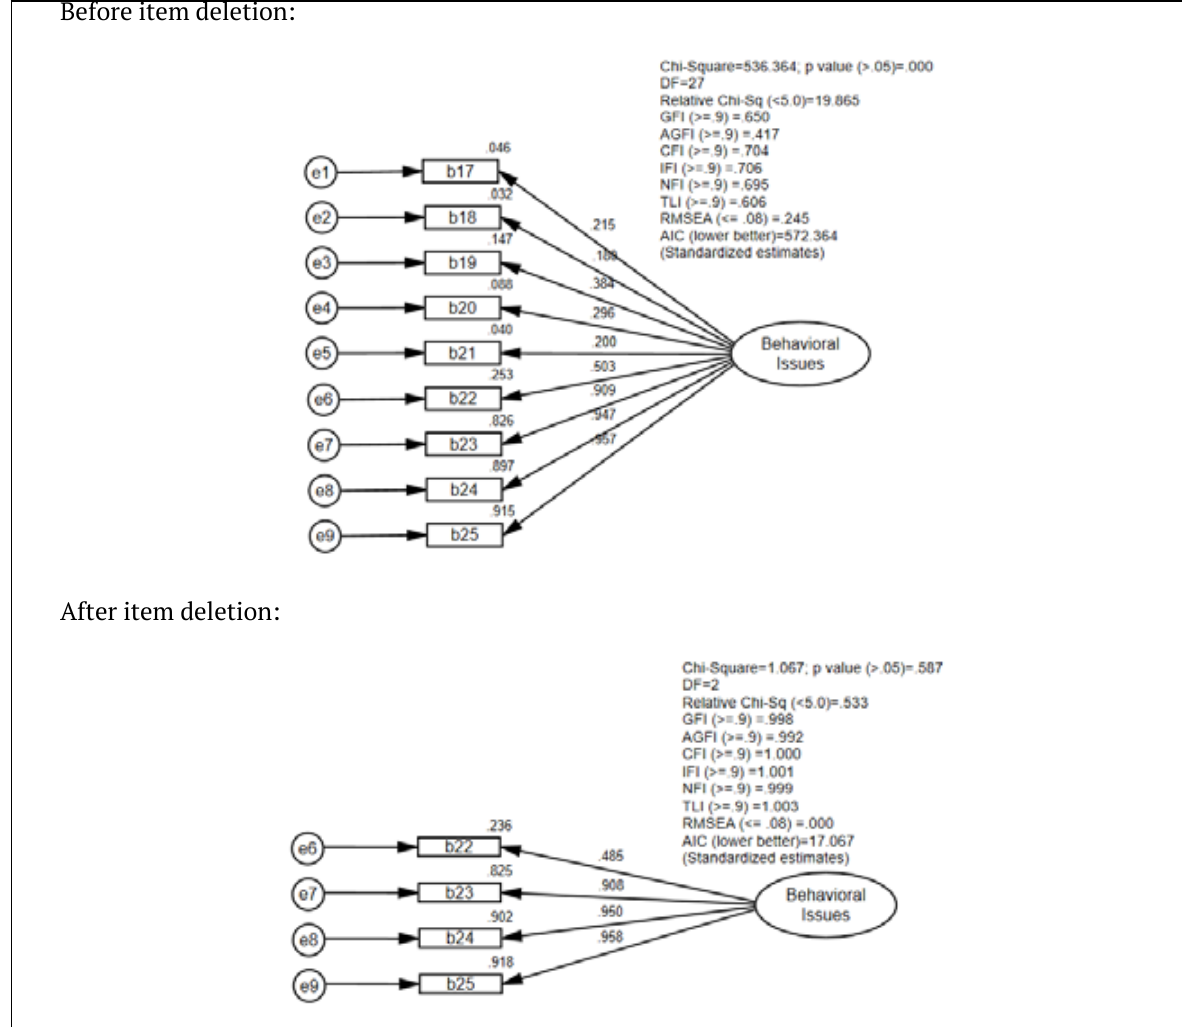
Figure 3. Confirmatory Factor Analysis for Behavioral